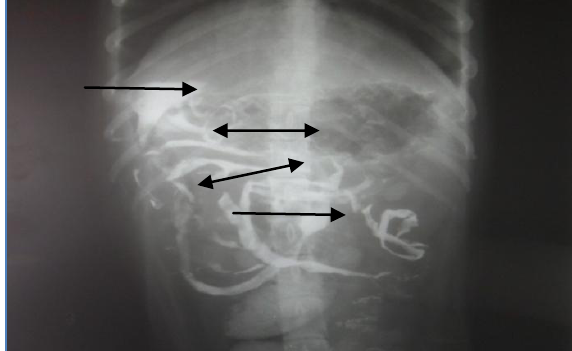
Figure, 1: Radiographic image of pyloric region showed patency of the pyloric canal at 21 st days post operation Ventro -Dorsal